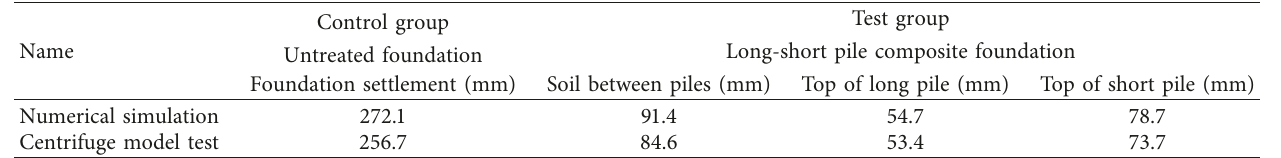
Table 5: Comparison of final settlement results of composite